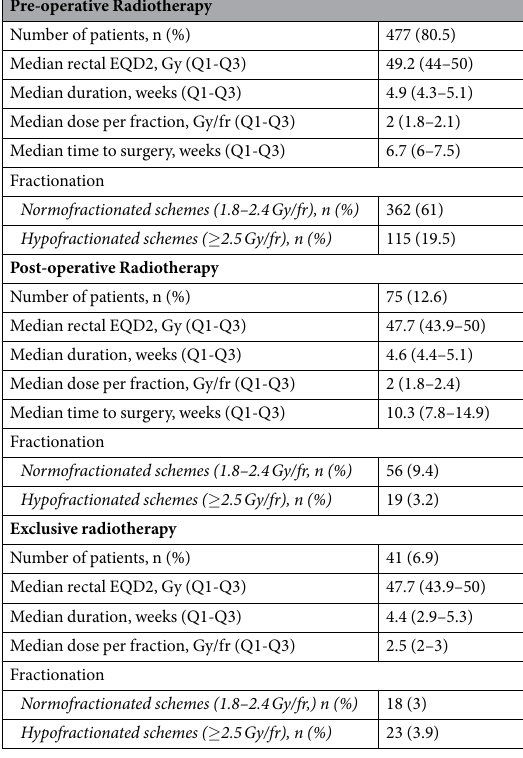
Table 2. Radiotherapy characteristics (n = 593 patients). Q1: first interquartile, Q3: third interquartile, EQD2: 2Gy-per-fraction equivalent dose, n: number of patients, Gy/fr: Gray per